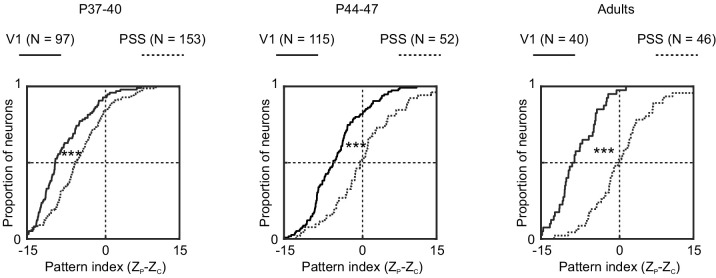
Motion integration levels in V1 are lower than those in PSS across development.Cumulative distribution of pattern indices for cells recorded in V1 (solid line) and PSS (dashed line) at different ages. Left: P37–40. Middle: P44–47. Right: Adults.***p<0.001.